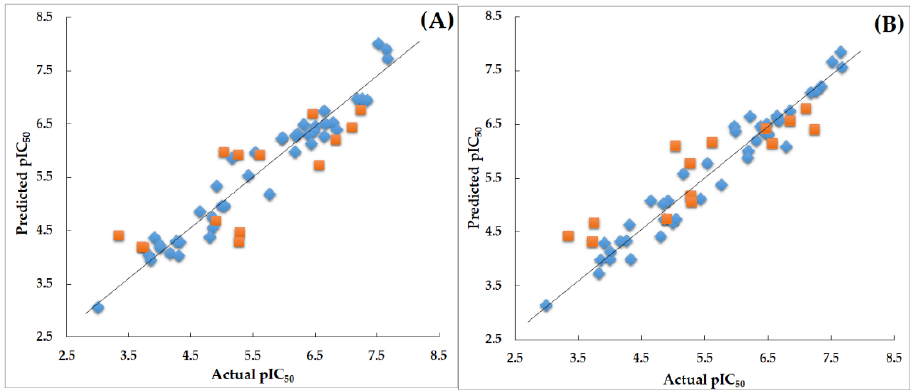
Figure 4. ( A ) Scatter plot for the selected CoMFA model; ( B ) Scatter plot for the selected CoMSIA model; the plot shows the actual pIC 50 versus predicted pIC 50 activity of training and test sets; the training set compounds are represented as blue diamonds; the test set compounds are represented as orange